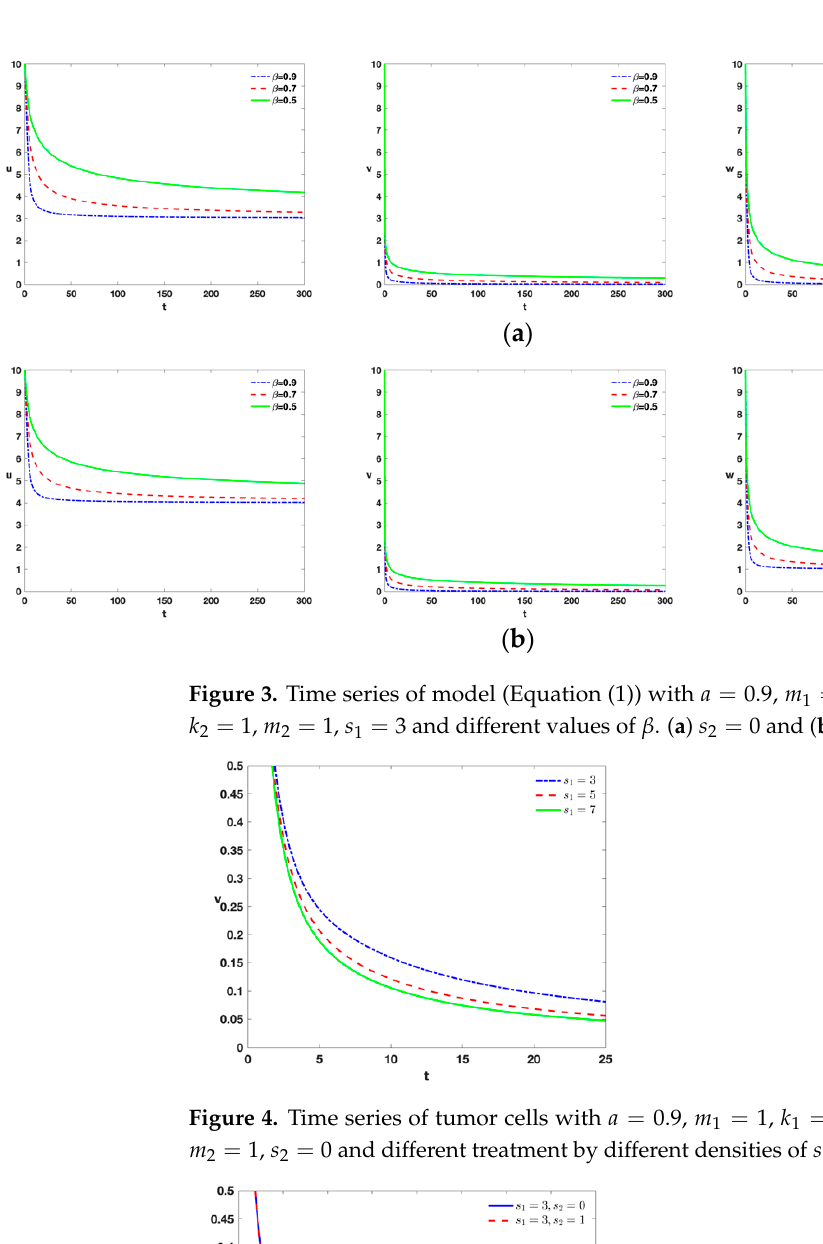
Figure 2. Time series ( a ) and phase diagram ( b ) of equilibrium point